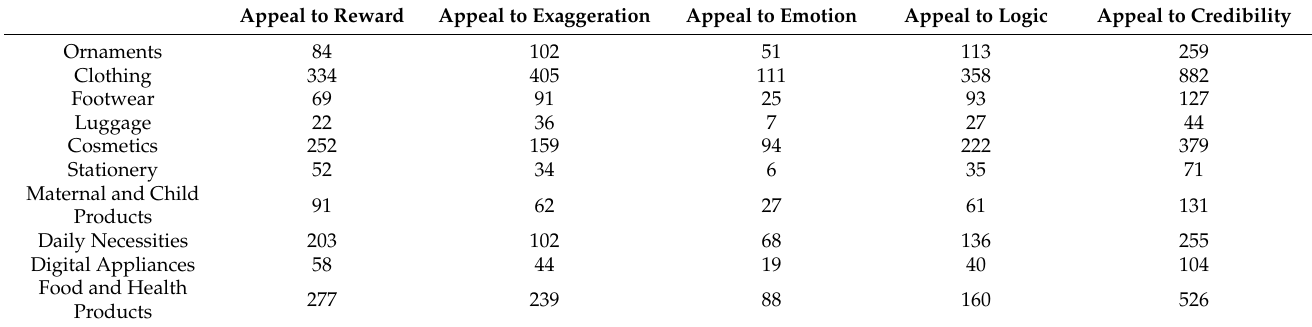
Table 5. Table of usage times of language styles of various